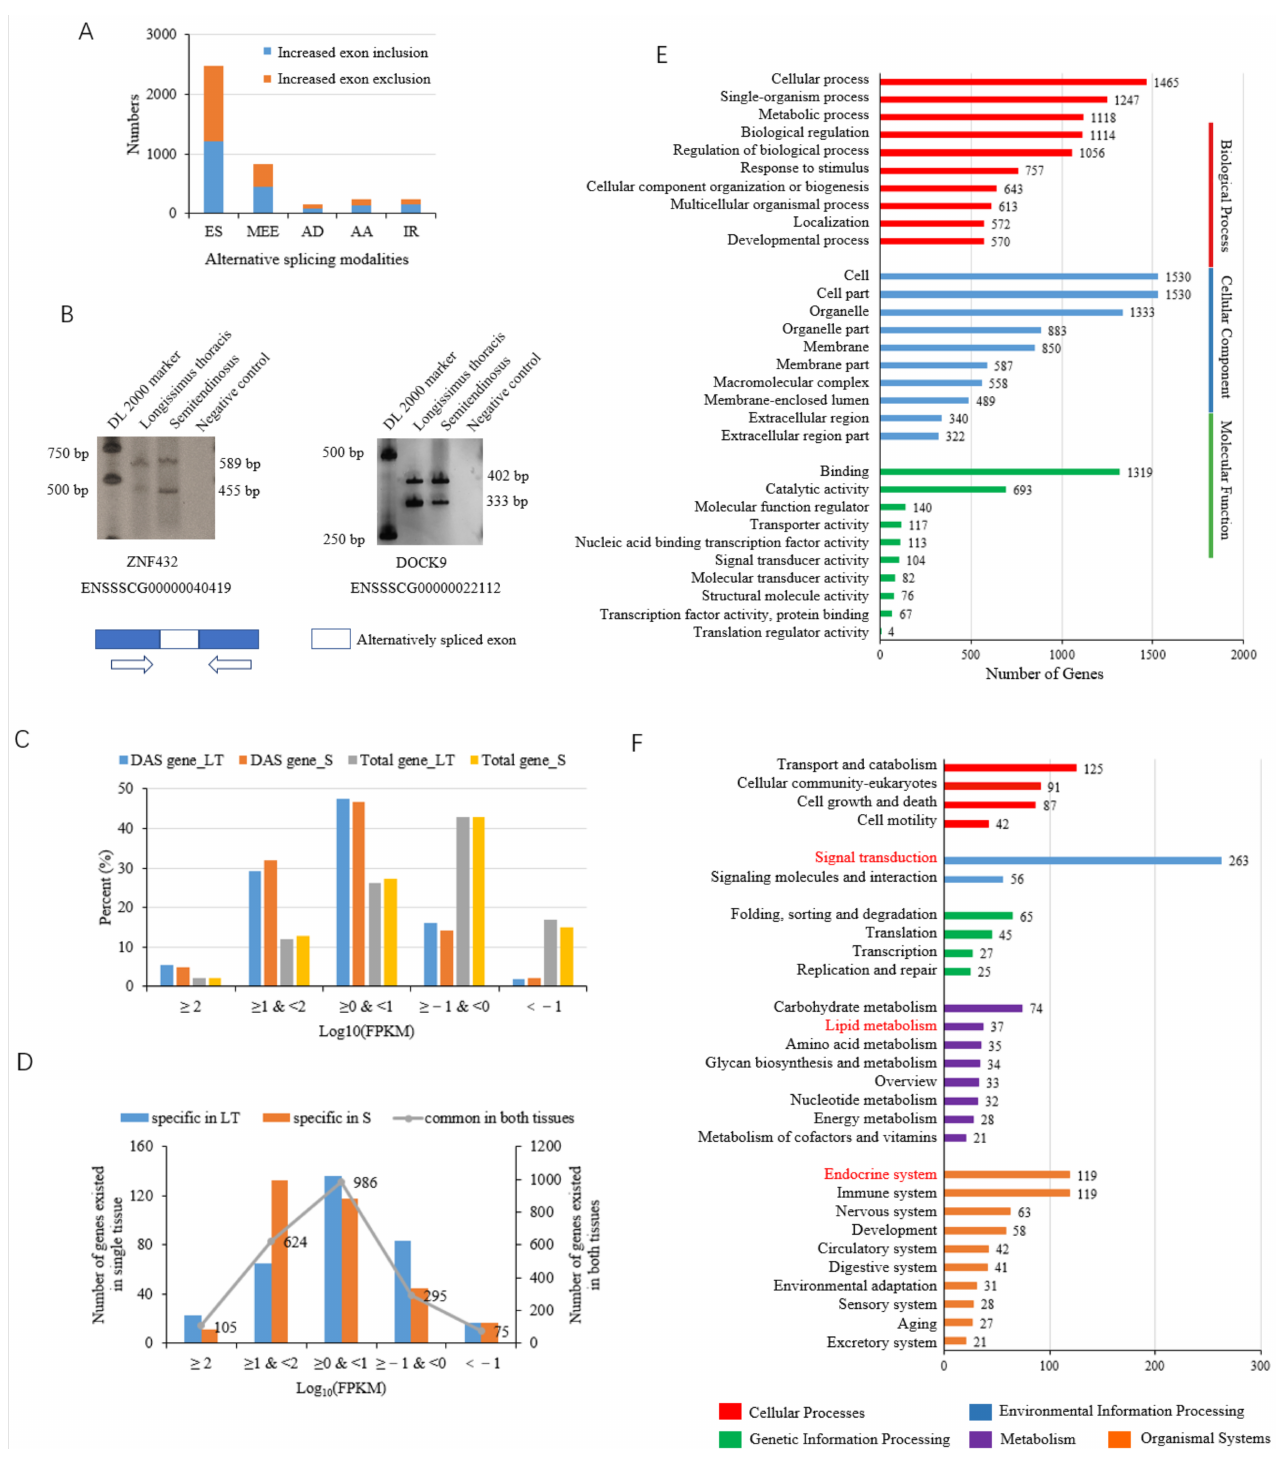
Figure 4. Characterization of differential alternative splicing (DAS) events through integrated analysis of Iso-seq and Illumina-seq. ( A ) Statistics of differential DAS events; ( B ) RT-PCR validation of DAS genes; ( C ) distribution of DAS genes with different expression levels compared to that of total genes identified; ( D ) comparison of expression level of DAS genes between longissimus thoracis and semitendinosus; ( E ) top 10 GO terms enriched by DAS genes in each functional category; ( F ) KEGG (Kyoto Encyclopedia of Genes and Genomes) pathways enriched with over 20 DAS